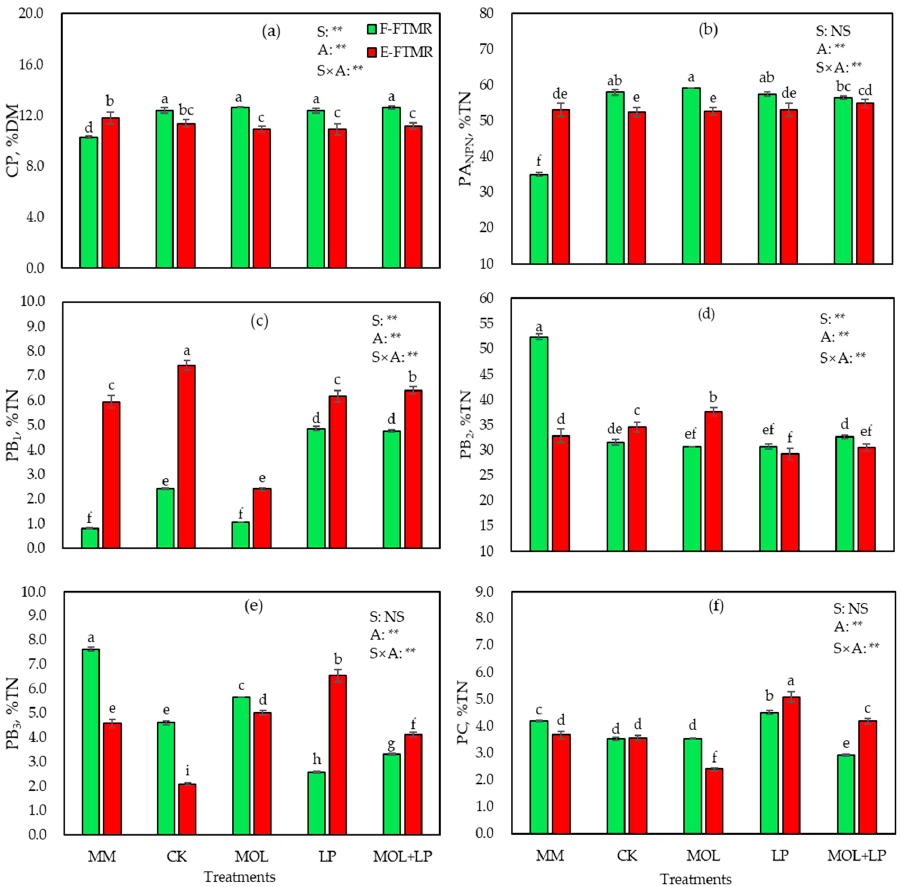
Figure 1. The protein fractions (CNCPS) of fresh-alfalfa FTMR and ensiled-alfalfa FTMR before fermentation and at 60 d fermentation in ( a ) CP, crude protein; ( b ) PA NPN , not applicable protein; ( c ) PB 1 , fast degradable protein; ( d ) PB 2 , variable protein; ( e ) PB 3 , variable to slow protein; and ( f ) PC, indigestible protein (bars indicate standard error of the means). F-FTMR represents the FTMR based on fresh-alfalfa. E-FTMR represents the FTMR based on ensiled-alfalfa. MOL, LP, and MOL+LP represent the addition of molasses, Lactobacillus plantarum and molasses mixed with L. plantarum , respectively. CK represents the addition of an equal amount of distilled water to the diets. DM represents dry matter, TN represents total nitrogen, and MM represents the mixed material before fermenting. A denotes significance of the additive; S denotes significance of two fermented style of FTMR; A × S denotes significance of the interaction between the additive and style. The asterisks (** p ≤ 0.01) indicate the significance of FTMR styles and additives and their interaction effects, and the difference at the specified ensiling day. NS, no significance. a–i Means significant difference among MM and all treatments at 60 d of fermentation ( p <